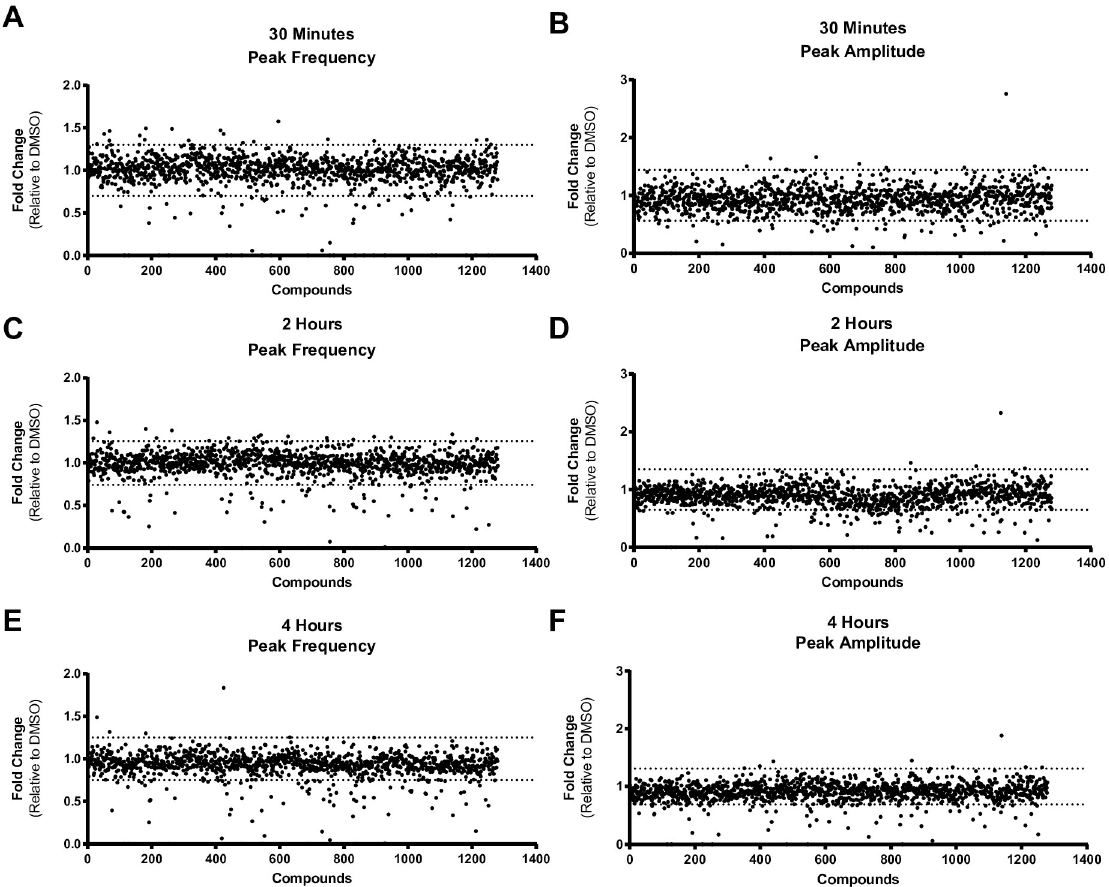
Fig 3. Screen with 1280 pharmacologically active compounds. Scatter plots of peak frequency at A) 30 minutes, C) 2 hours, and E) 4 hours after compound addition. Scatter plots of peak amplitude at B) 30 minutes, D) 2 hours, and F) 4 hours after compound addition. Each dot represents the average of duplicate wells relative to DMSO treated wells. Dashed lines indicate +/- two-times the standard deviation of the DMSO wells. Compounds that fell above or below dashed lines were classified as hits.